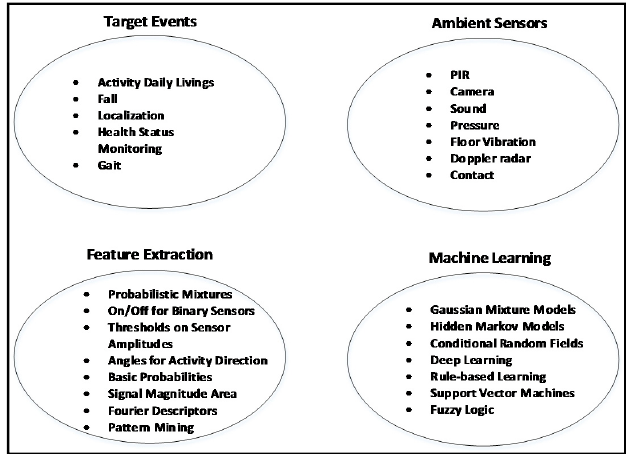
Figure 5. Different domains of ambient sensor-based elder care systems.